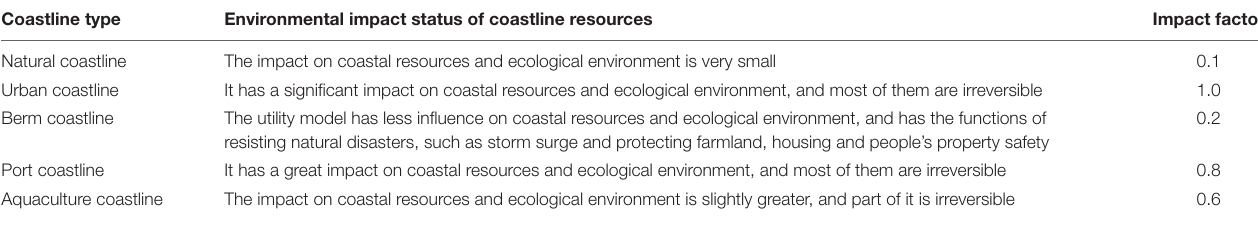
TABLE 3 | Resource-environmental impact factors of different